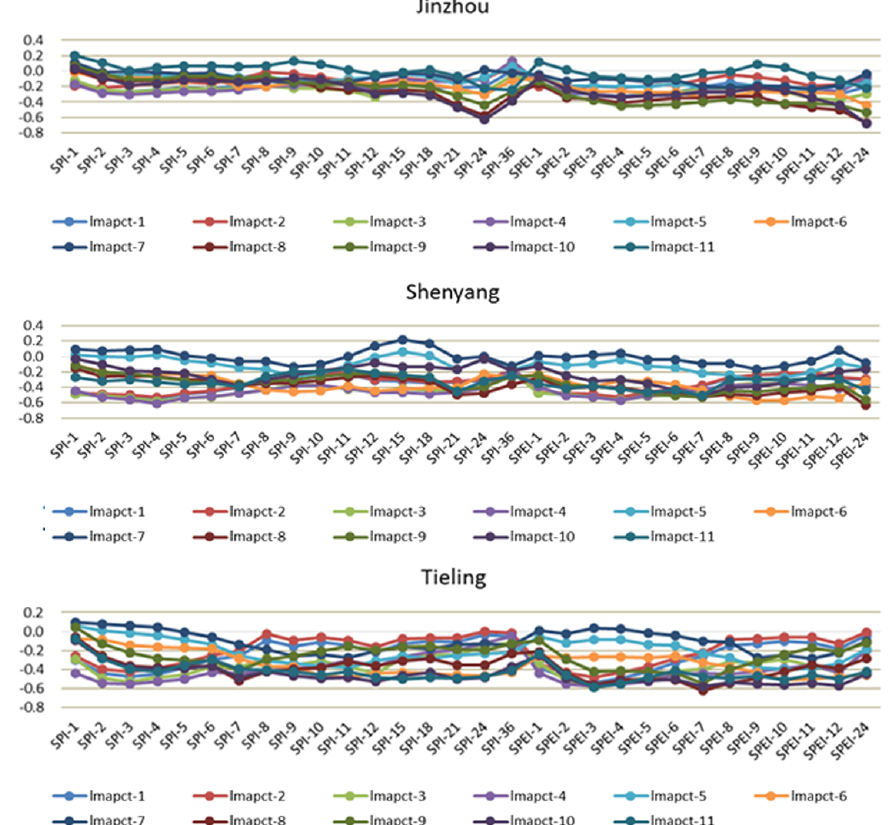
Figure 3. Correlations between SPI/SPEI with different accumulation periods and the 11 drought impact indices in Jinzhou, Shenyang and